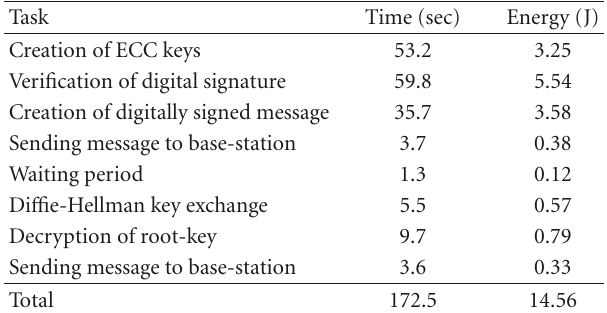
Table 3: Root-key distribution steps and their time/energy usage.